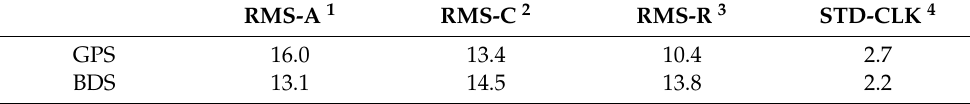
Figure 6. RMS values of BDS PPP-B2b orbit errors and STD values of clock errors. Table 3. The average STD and RMS of BDS-3/GPS PPP-B2b orbits and clock errors (unit: